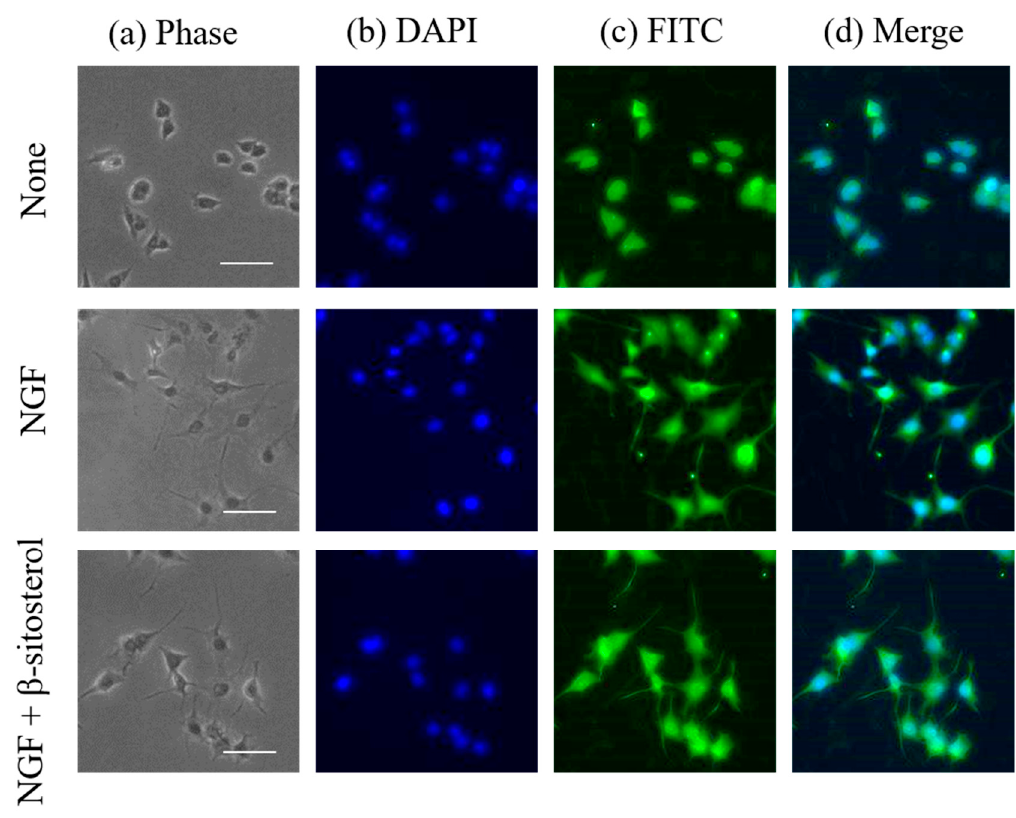
Figure 6. Immunostaining of neurofilaments of PC12 cells with differentiated neurites stimulated by β -sitosterol in the presence of NGF. PC12 cells were incubated for 48 h without or with NGF (10 ng / mL) and β -sitosterol (0.5 µ M) or with NGF (10 ng / mL) alone. Immunostaining was performed with rabbit anti-neurofilament antibody, followed by treatment with fluorescein isothiocyanate-conjugated goat anti-rabbit IgG. The nuclei of PC12 cells were treated with 4 (cid:48) ,6-diamidino-2-phenylindole (blue) and examined under a fluorescence microscope. ( a ) Phase contrast, ( b ) DAPI-treated nuclei, ( c ) green fluorescence for FITC-treated neurofilaments and ( d ) merged images. Scale bar = 50 µ